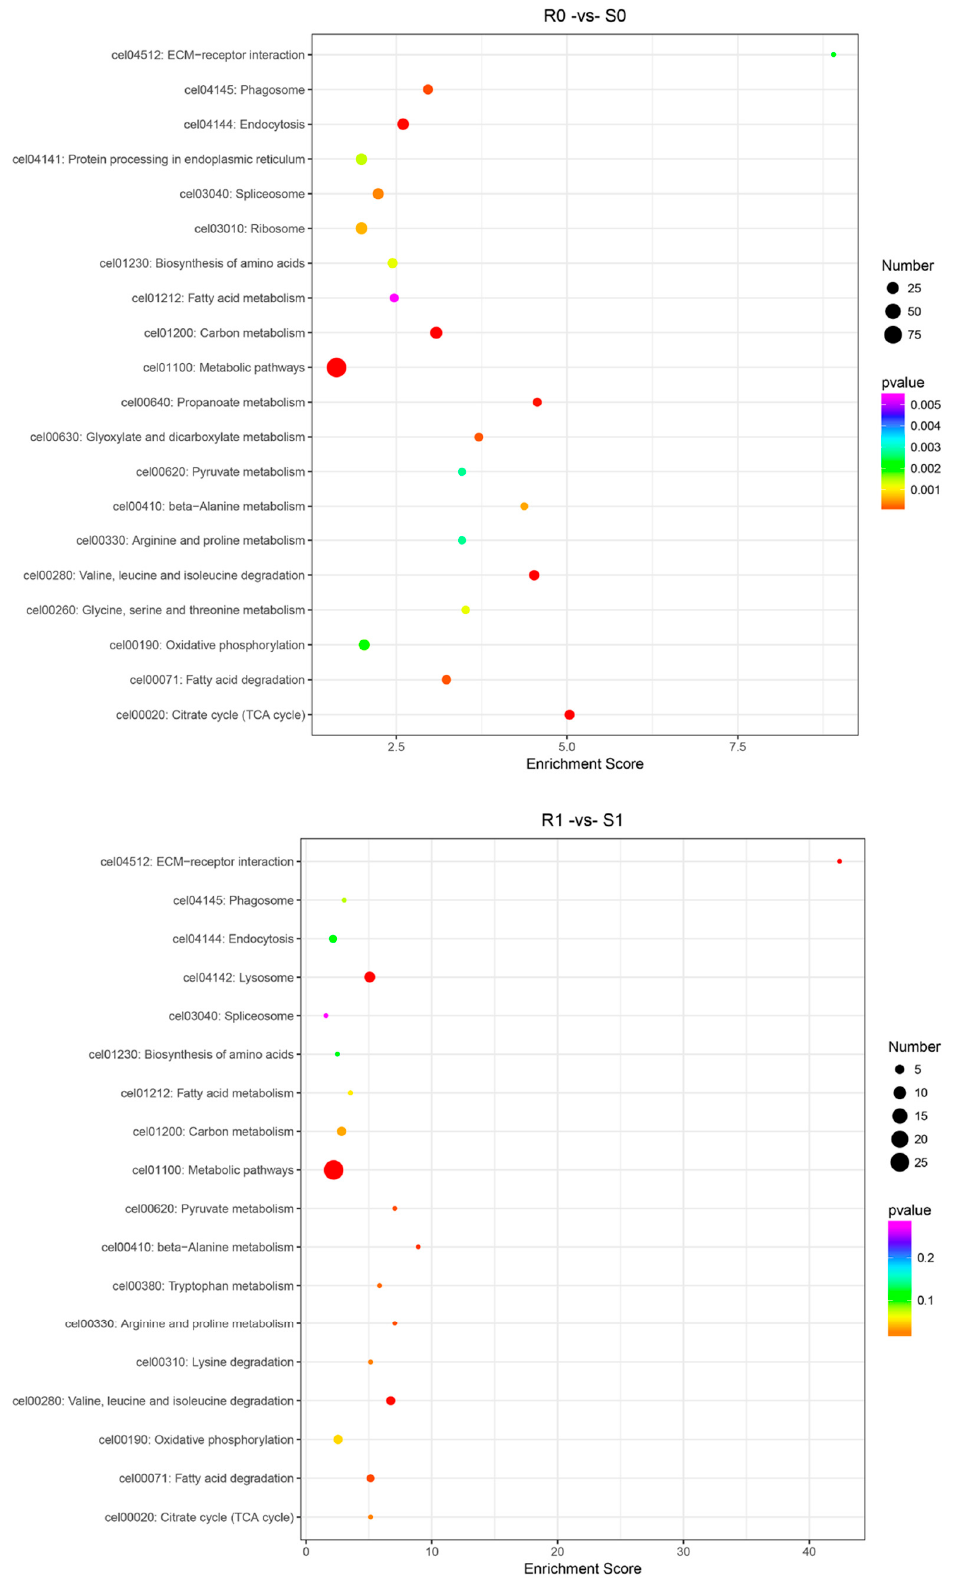
Figure 8. Scatterplot of the top 20 most enriched KEGG enrichment pathways for the DEPs in the four comparison groups. The X -axis indicates enrichment score, and the Y -axis represents the distinct KEGG pathways. KEGG